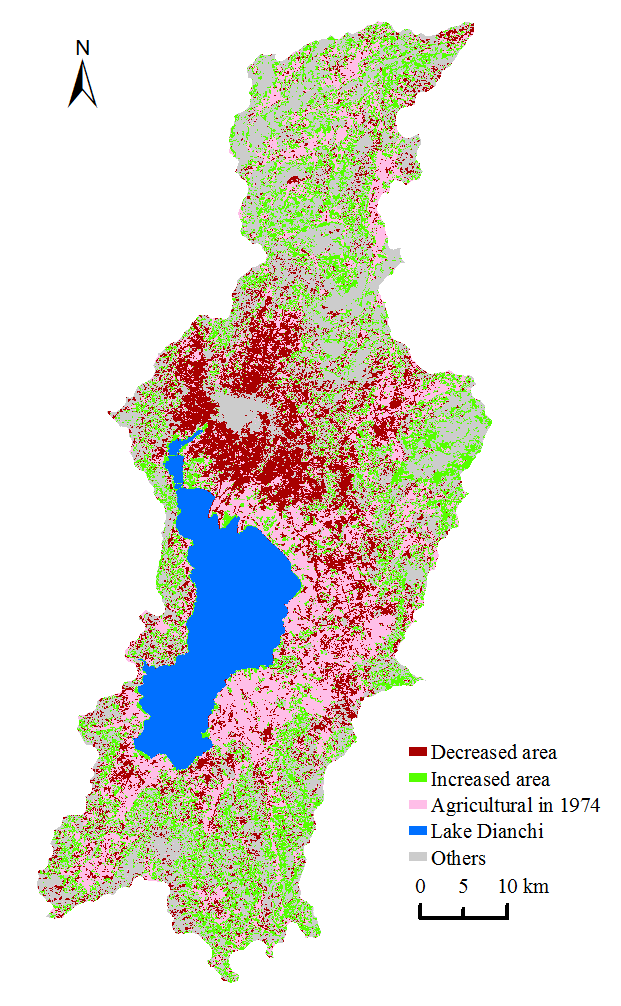
Figure 7. Transformation into and out of agricultural land from